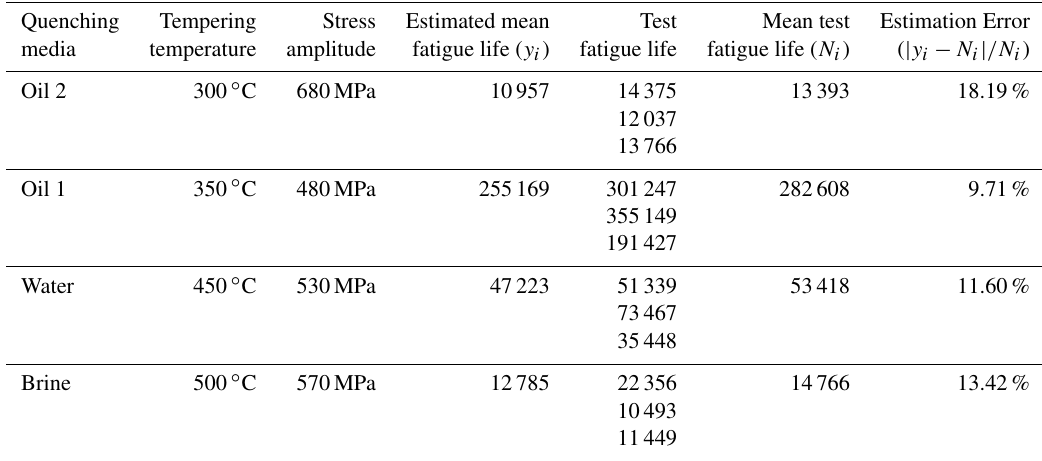
Table 5. Validation of the estimation method based on RBF neural network for mean fatigue